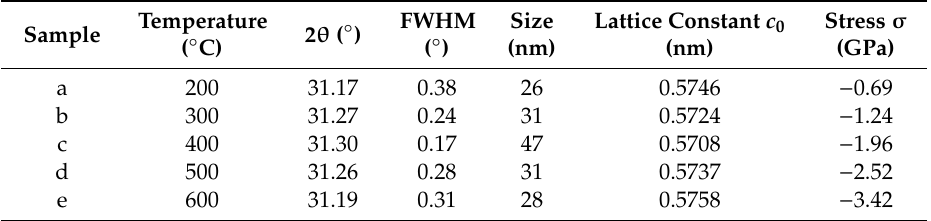
Figure 2. XRD patterns of InN thin films deposited at ( a ) 200 ◦ C, ( b ) 300 ◦ C, ( c ) 400 ◦ C, ( d ) 500 ◦ C and ( e ) 600 ◦ C. Table 1. InN (0002) diffraction peak position, full width at half maximum (FWHM), grain size, lattice constant and stress.